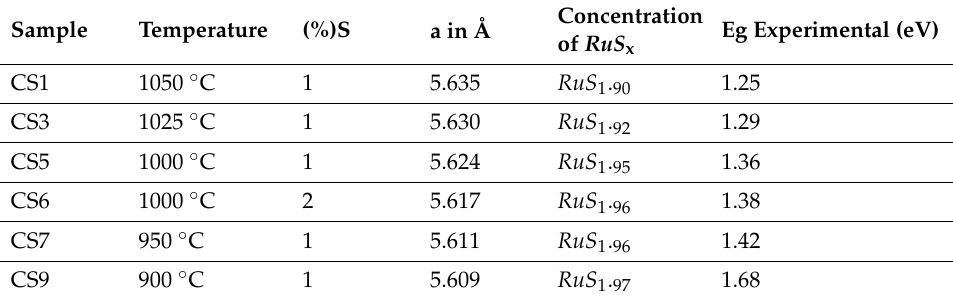
Figure 4. Parameter of structure ν versus temperature.